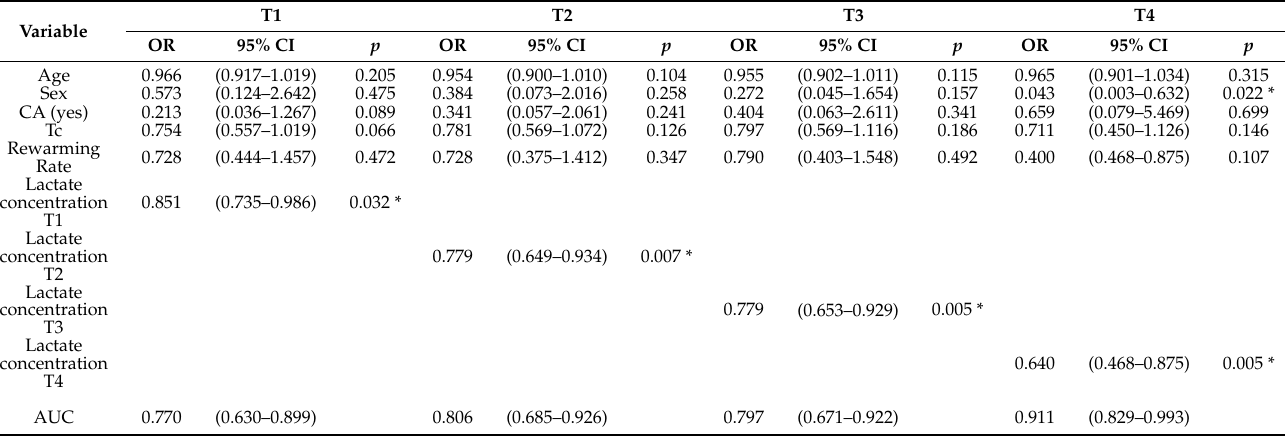
Table 4. Relationship between survival, age, gender, CA onset, body temperature, rewarming rate, and lactate concentration from T1 to T4 time